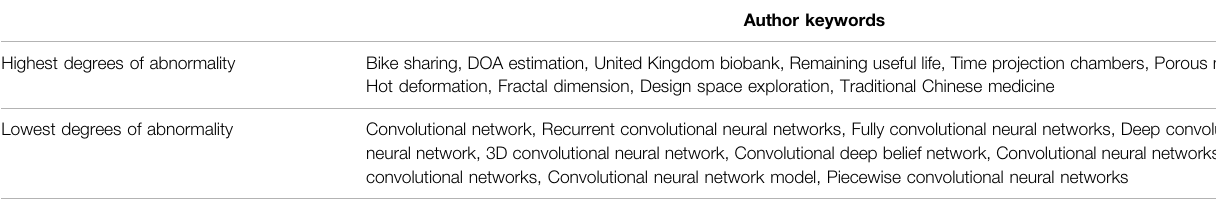
TABLE 1 | Top 10 author keywords with the highest and lowest degrees of abnormality.